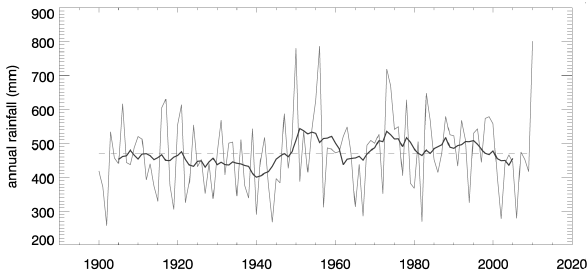
Fig. 2. Area-average annual (January–December) rainfall (thin grey line) and decadal mean rainfall (thick black line) for the Murray- Darling Basin from 1900 to 2010, generated from the Australian Water Availability Project rainfall grids (Jones et al., 2009a). The dashed line indicates the mean annual rainfall total over the 1900– 2010 mean